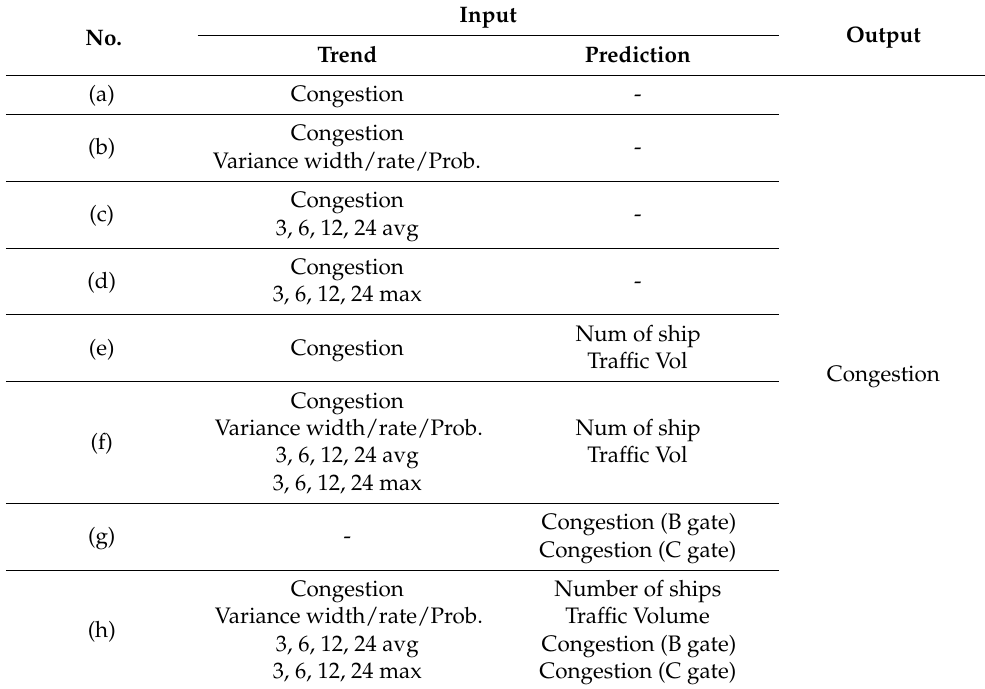
Table 3. Configuration of training and experimental